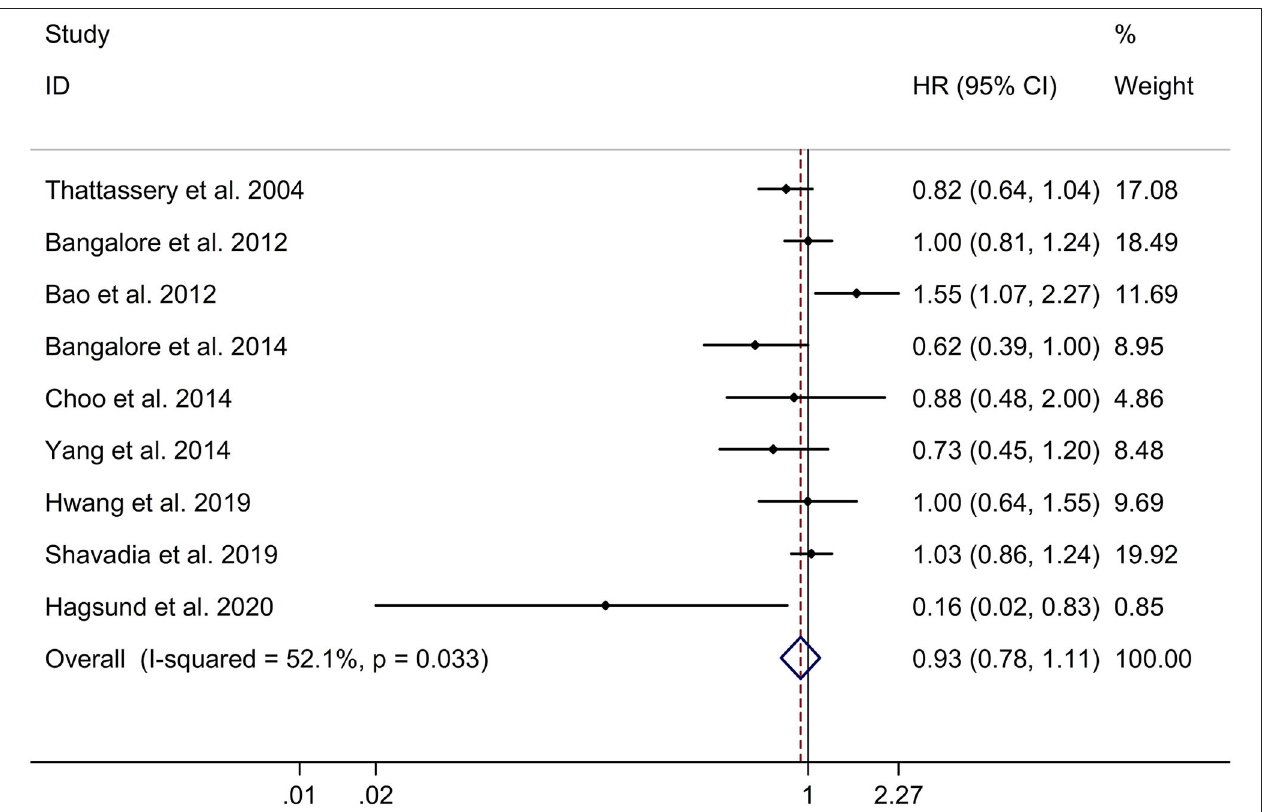
FIGURE 4 | Forest plots exploring the long-term effect of β -blocker use on risk of recurrent MI in patients after MI. CIs, confidence intervals; HRs, hazard ratios; MI, myocardial